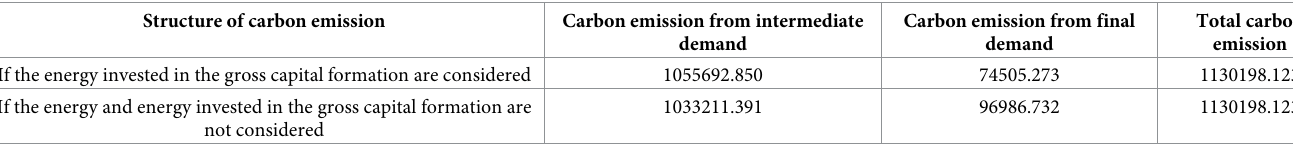
Table 3. Detailed results of carbon emission under two scenarios. Structure of carbon